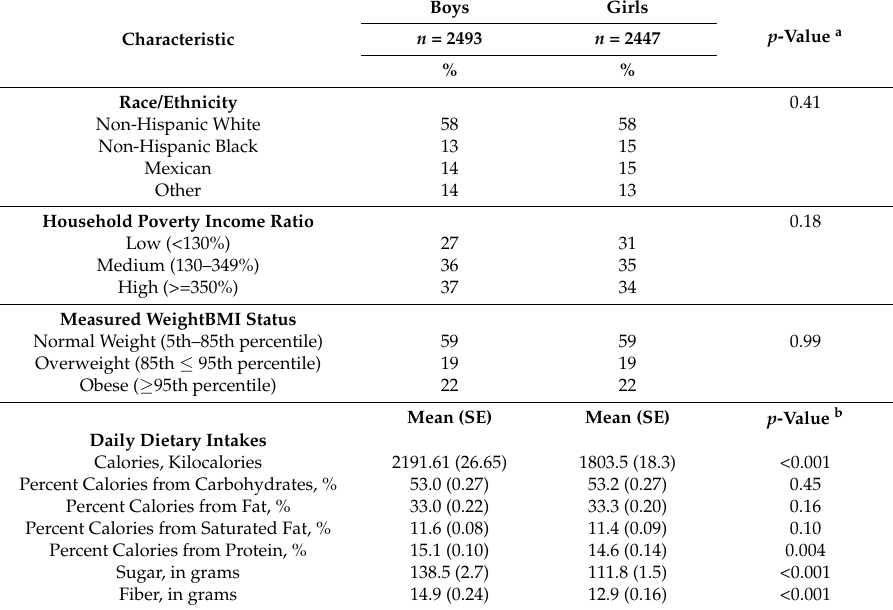
Table 1. Distributions of selected characteristics of adolescents ages 10–15 years, stratified by gender, participating in the National Health and Nutrition Examination Survey NHANES 2005–2014 ( n = 4940).